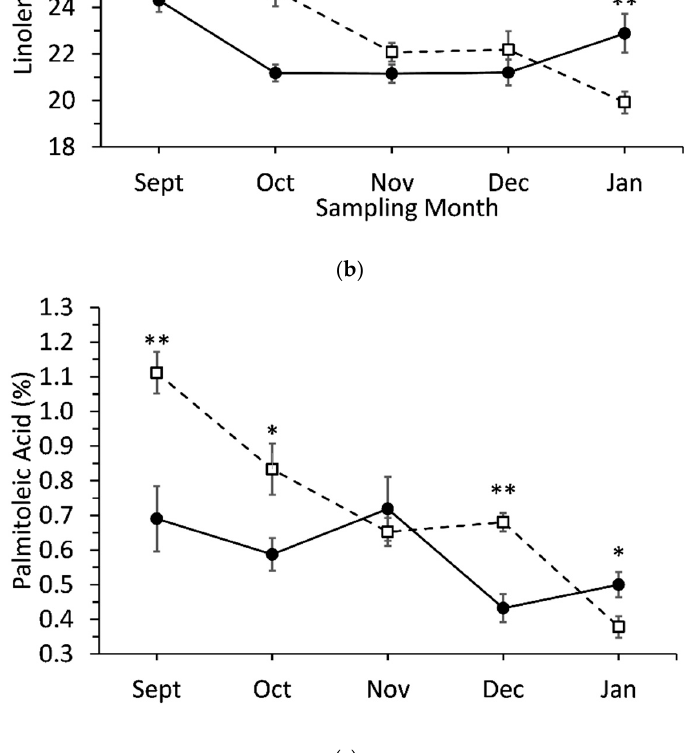
Figure 6. Interactive effects between balsam fir genotype (low and high needle abscission resistance) and sample collection date for ( a ) palmitic acid, ( b ) linolenic acid, and, ( c ) and palmitoleic acid. Each data point represents a mean ± standard error as calculated from of 10 branches. The * indicated 1% to 5% significance and the ** indicates less than 1% significance between genotypes at any month.